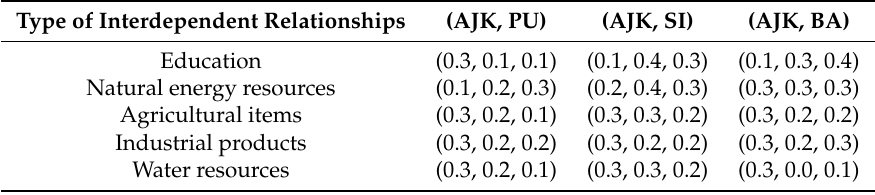
Table 5. IN set of interdependent relationships between AJK and other provinces. Type of Interdependent Relationships